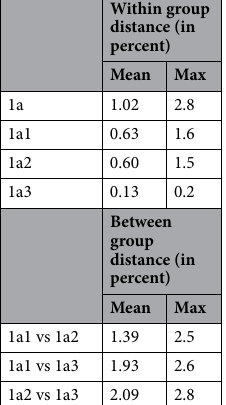
Within group distance